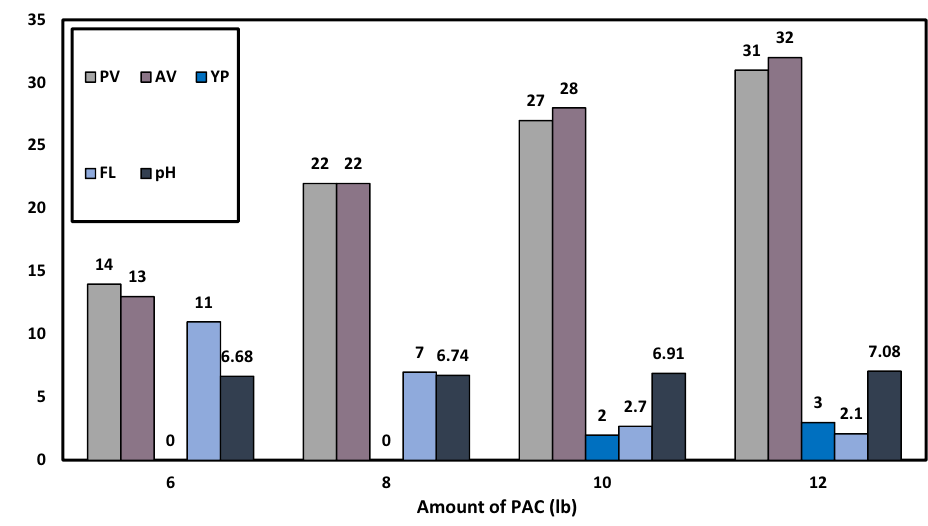
Fig. 5 Comparison of different concentrations of PAC